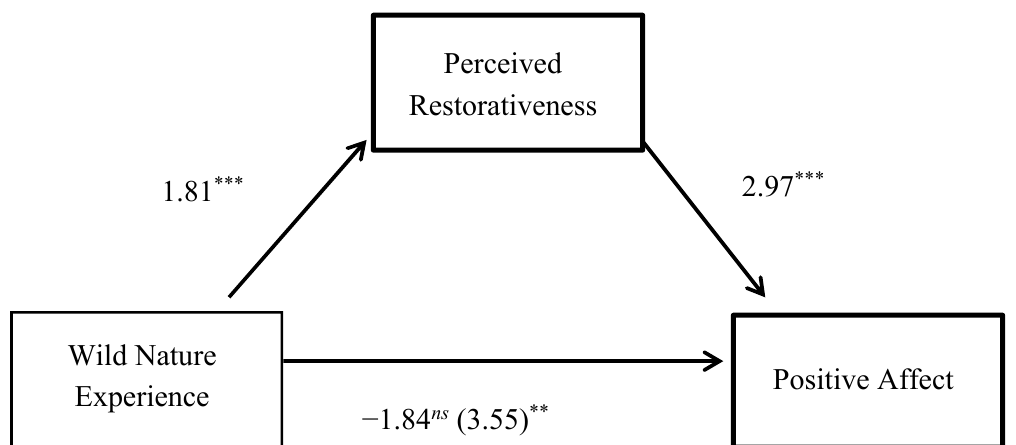
Figure 1 . Perceived restorativeness as a mediator of the relationship between the virtual wild nature experience and positive affect. All paths are unstandardized beta coefficients [39]. The value in parenthesis represents the relationship between the wild nature experience and positive affect prior to controlling for perceived restorativeness. N = 144, ** p < 0.01, *** p < 0.001, ns = not significant.